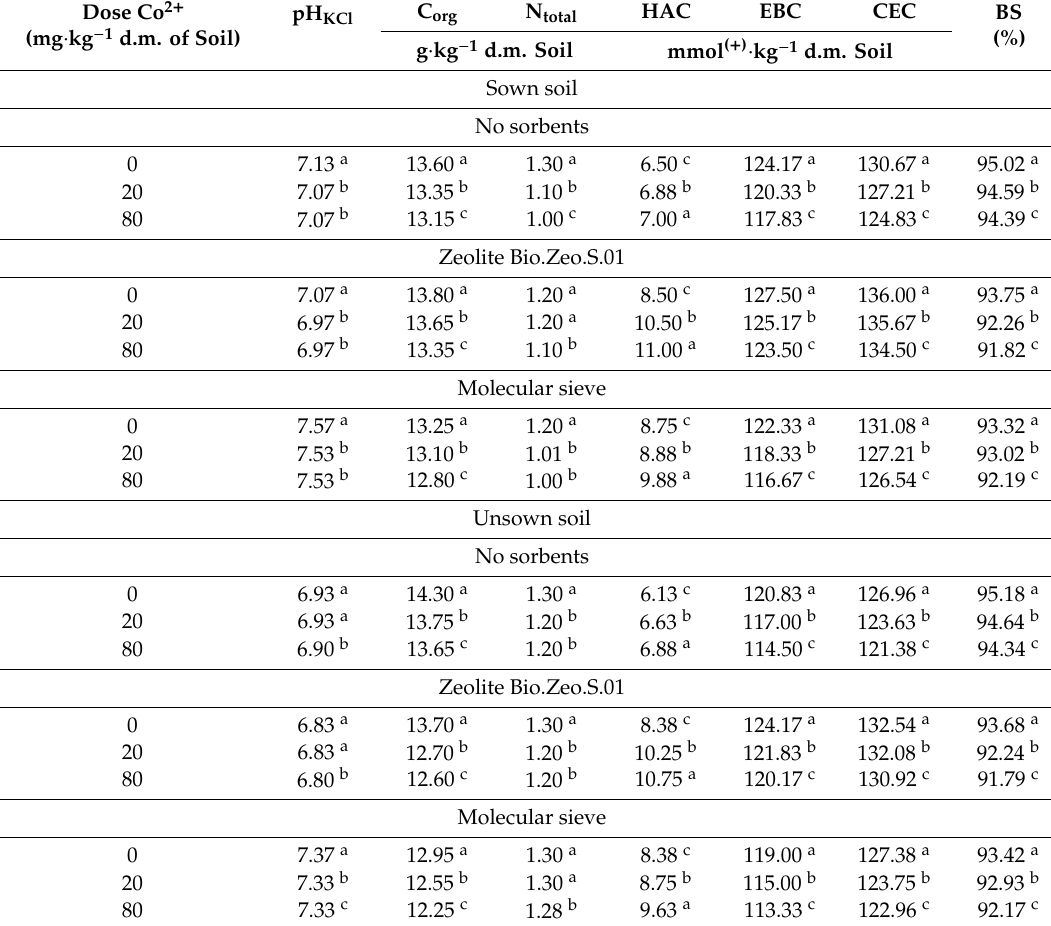
Table 17. Physicochemical properties of sandy clay loam, contaminated with cobalt, with the addition of a molecular sieve and